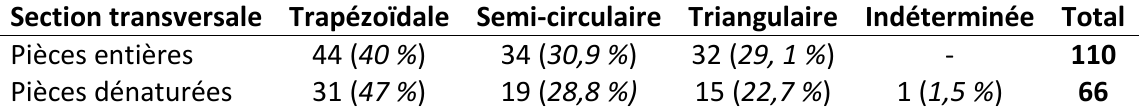
Figure 14. Exemples théoriques d’évolution des pièces façonnées unifacialement au cours de leur vie à partir de spécimens de la collection de GO-JA-01. 1, 2b, 3 et 4 : Schéma de réaménagement I ; 2.a : Schéma de réaménagement II. Figure 14. Theoretical examples of transformation of unifacially shaped artefacts throughout their use-life (based on artefacts from GO-JA-01 rockshelter). 1, 2b, 3 and 4: Restructuration scheme I; 2a: Restructuration scheme II. Tableau 3. Pièces façonnées unifacialement entières et dénaturées de GO-JA-01. Décompte et pourcentage des pièces pour chaque catégorie de section transversale. Table 3. Complete and exhausted unifacially shaped artefacts from GO-JA-01. Count and percentage of pieces in each transversal section